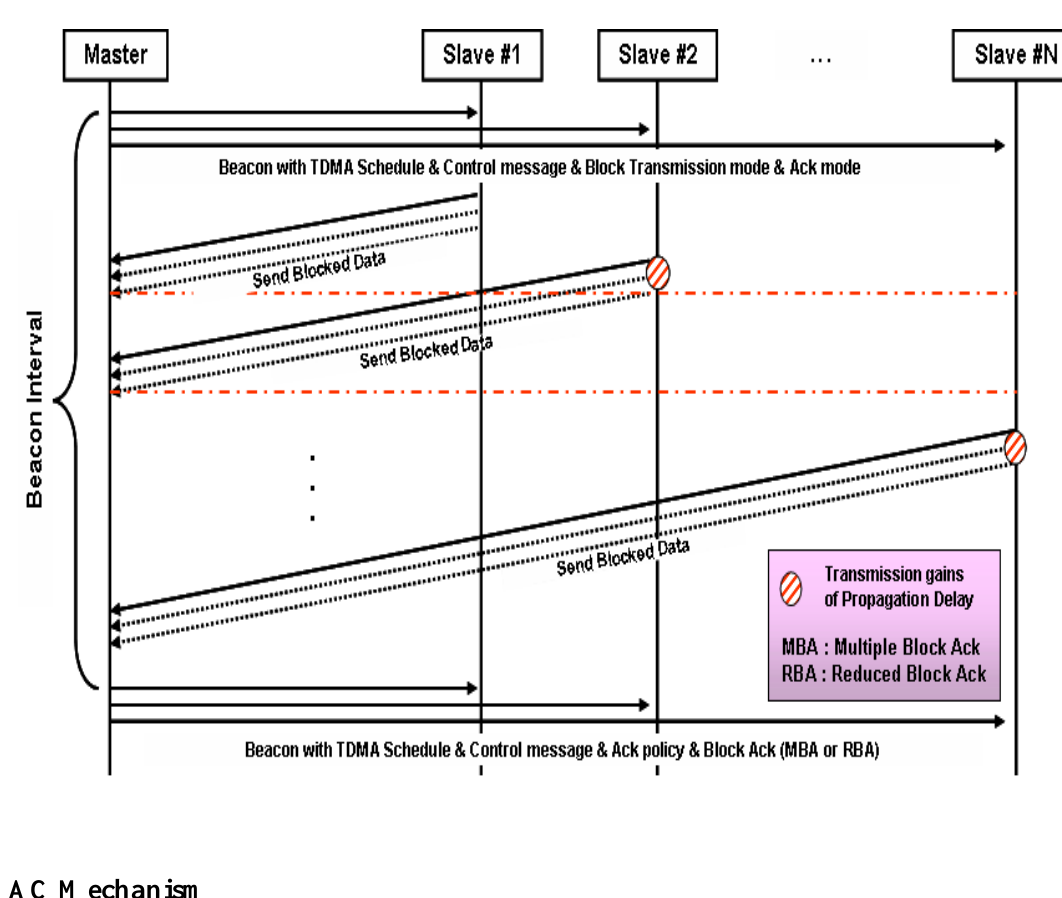
Figure 3. Blocked data